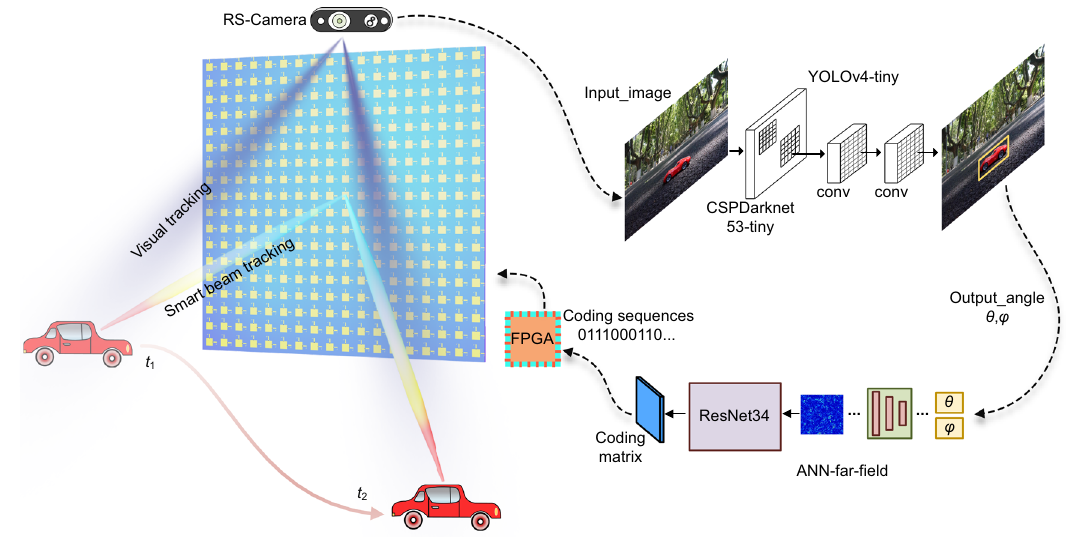
Fig. 1 | Schematic of the intelligent target tracking system. The RS-camera automatically detects the position of a moving target in the environment. The position information of the selected target is taken as the input of the pre-trained arti fi cial neural network (ANN), and the coding sequence of the metasurface is